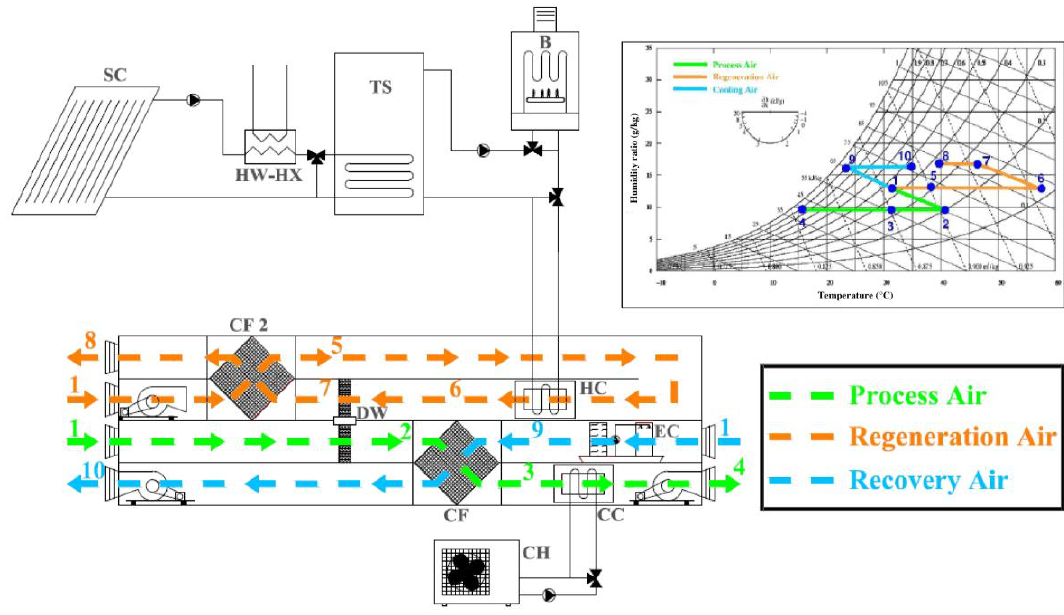
Figure 4. Scheme of the desiccant-based AHU with cross-flow heat recovery unit and psychrometric diagram (cooling operation, Scenario C).